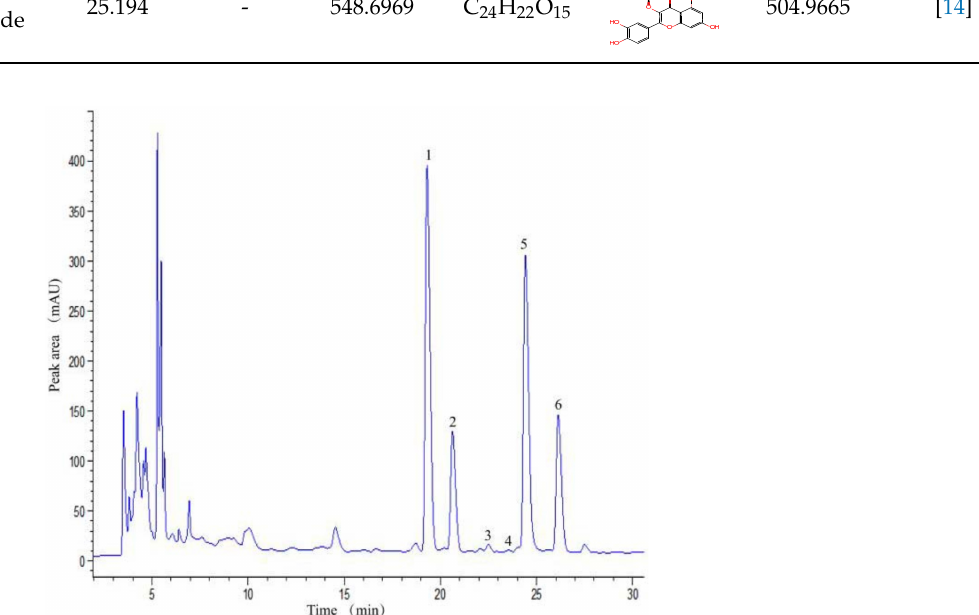
Figure 3. HPLC chromatogram of okra flavonoids (1. Q3G; 2. Q3S; 3. Rutin; 4. Q7G; 5. ISO; 6.